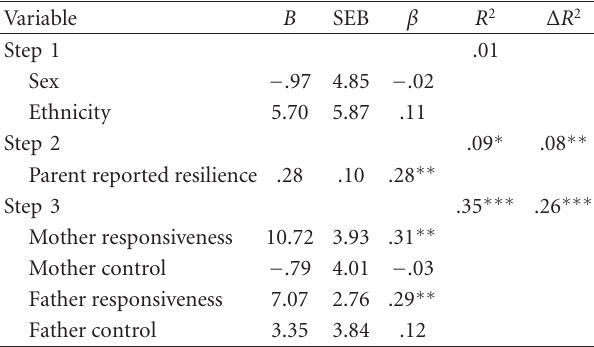
Table 5: Mother and father responsiveness and psychological control in predicting child emotional resilience after controlling sex, ethnicity, and parent-reported child emotional resilience ( N =